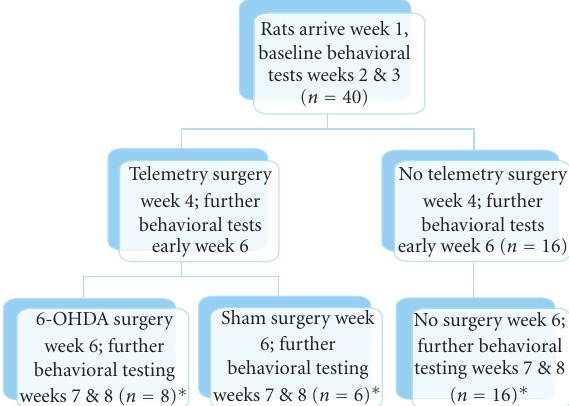
Figure 1: Flow chart illustrating study design. Note that whilst 40 rats were employed, 10 were excluded due to either surgical complications or mistargeting of the 6-OHDA lesion. ∗ final number employed in data